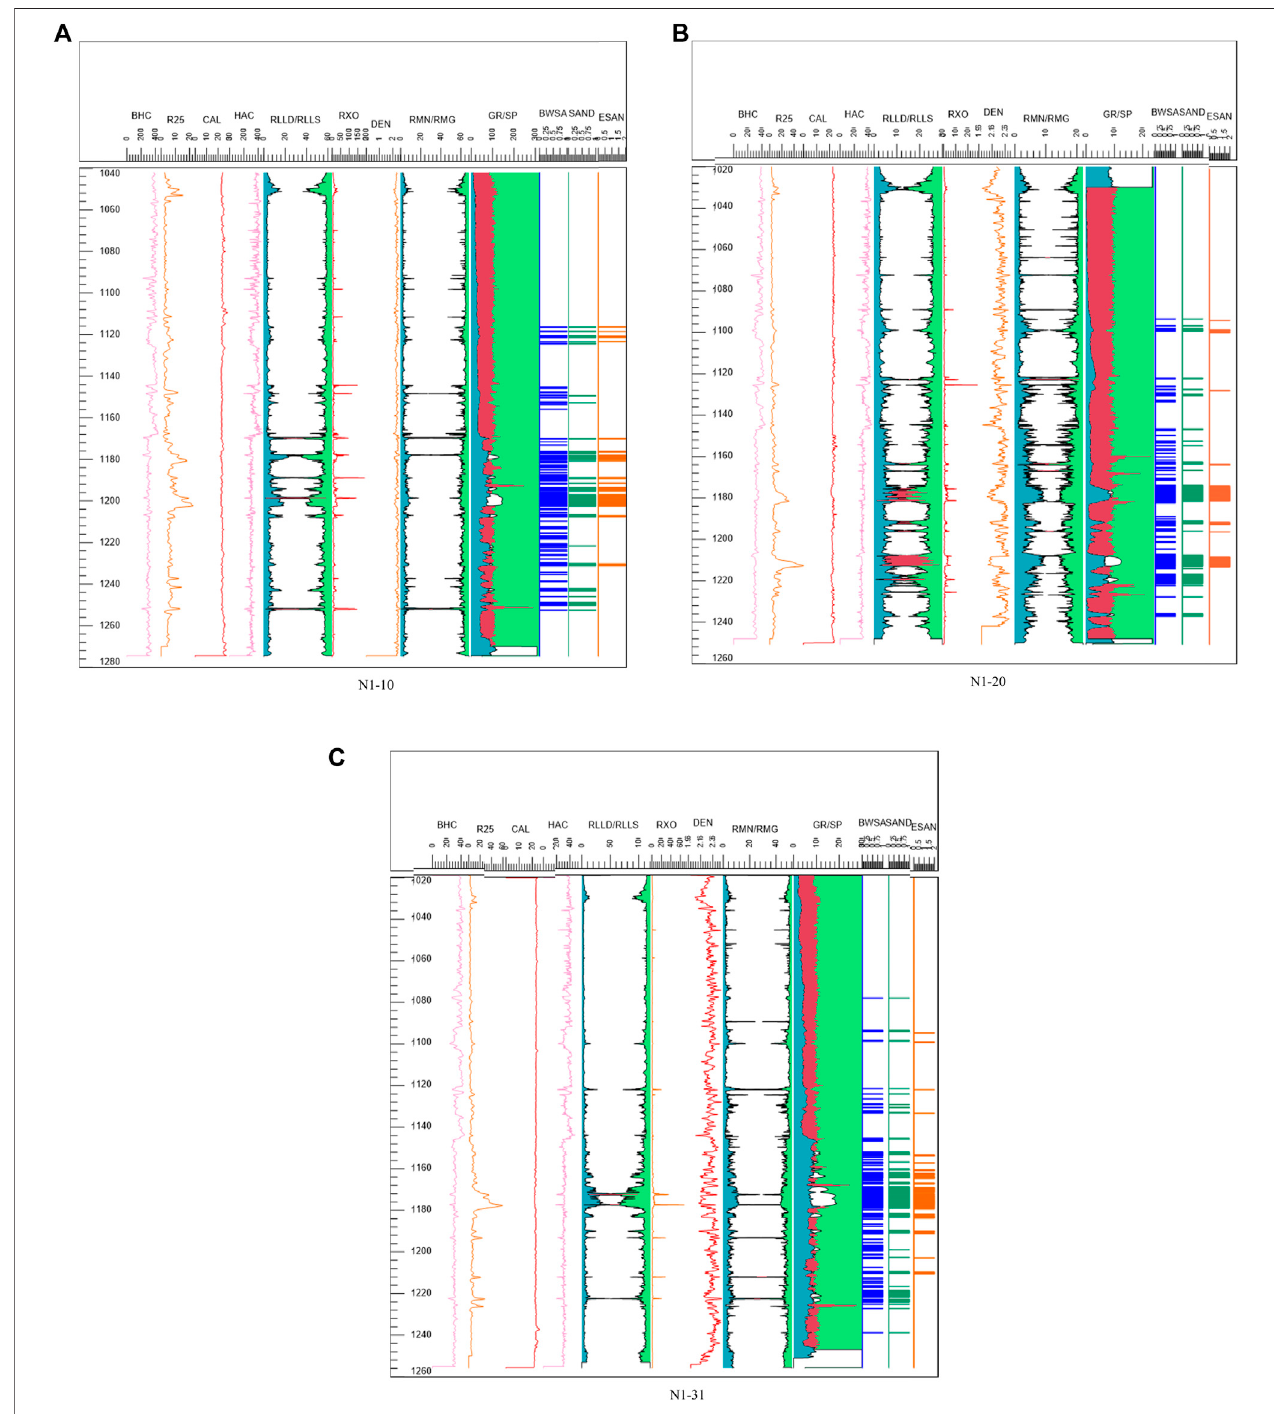
FIGURE 7 | Interpretation results of three wells. (A) N1-10. (B) N1-20. (C) N1-31.